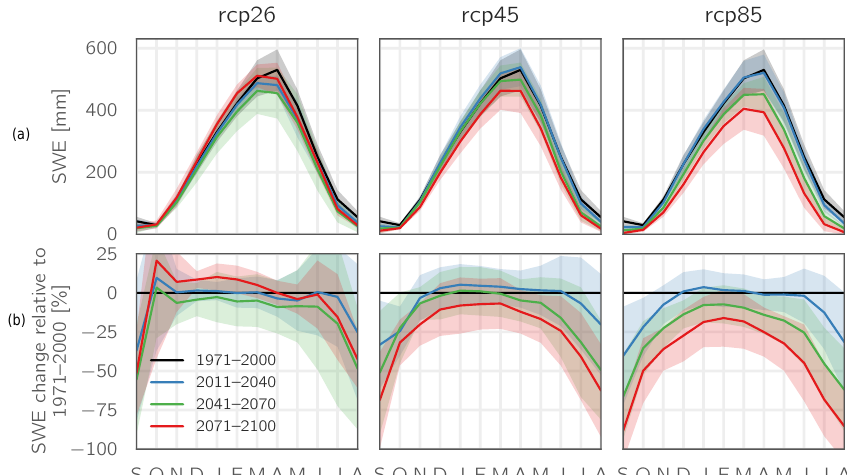
Figure 10. Mean monthly SWE (multi-model means; shadings indicate ± one standard deviation) over the entire study area (Fig. 1) for the three RCPs (a) and relative changes compared to 1971–2000 (b)